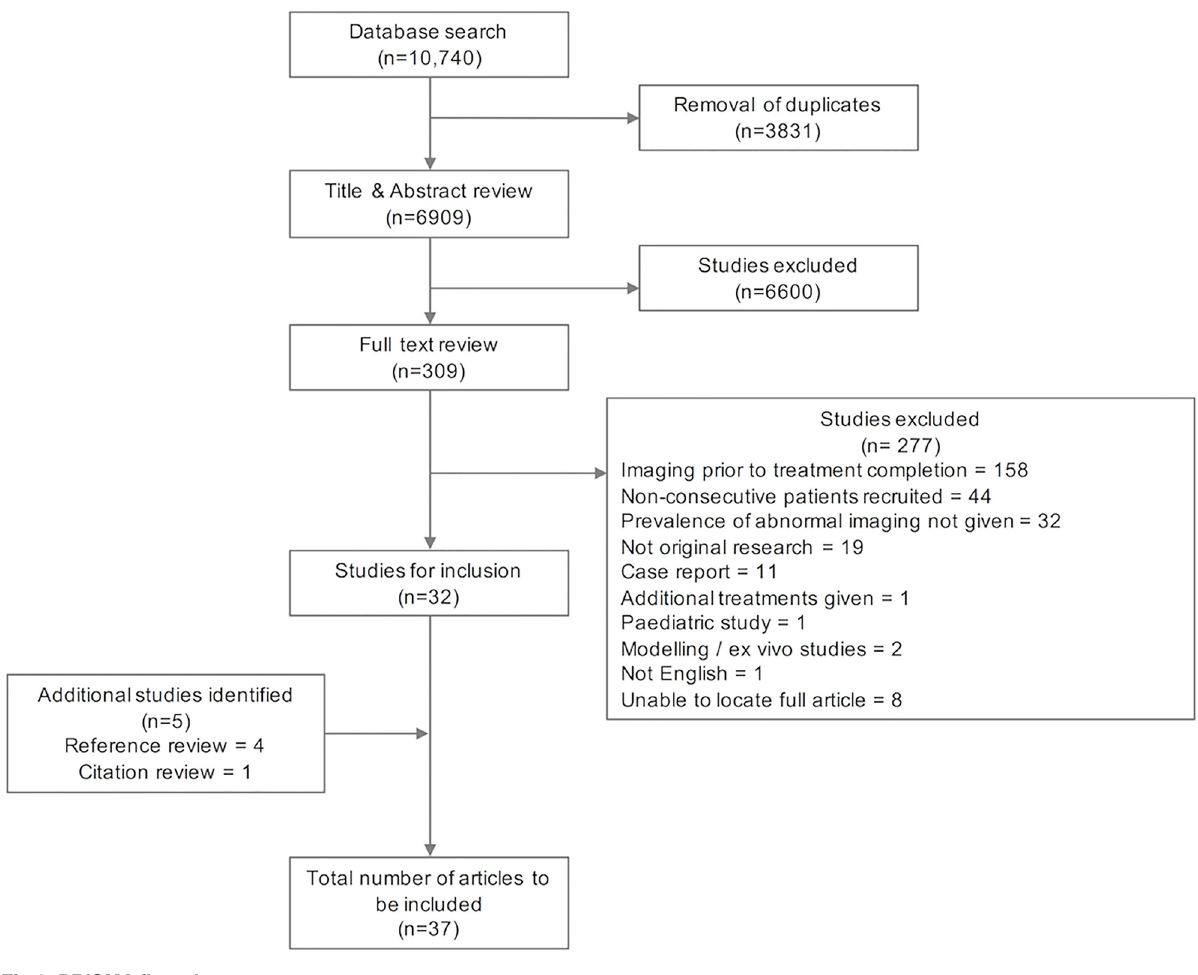
Fig 1. PRISMA flow